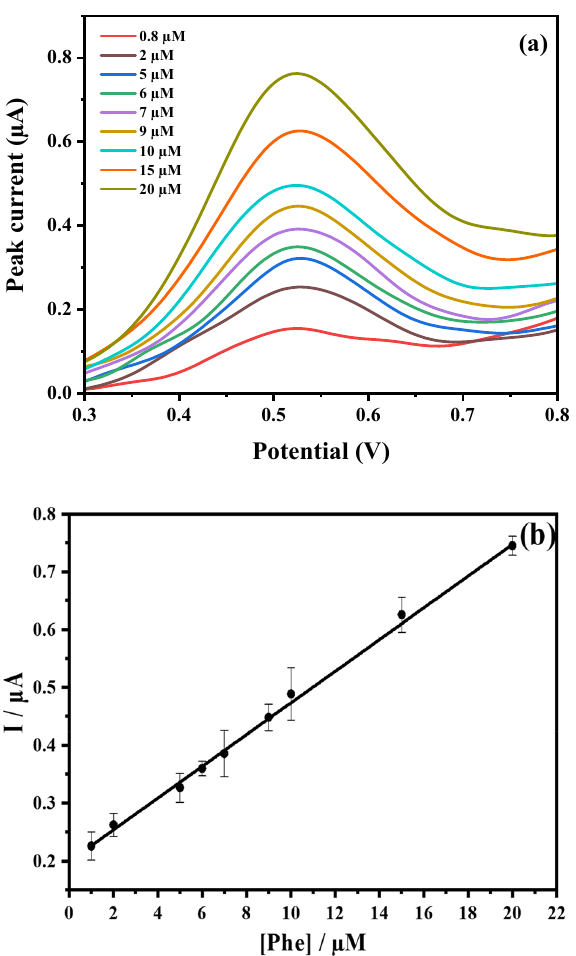
Figure 7. ( a ) DPV voltammogram recorded at AgNPs-M/GCE for increasing phenol concentrations (0.8, 2, 5, 6, 7, 9, 10, 15 and 20 µM) in PBS (0.1 M, pH 7.0), at the pulse time of 100 ms, pulse amplitude of 100 mV and at the scan rate of 60 mV s −1 ; ( b ) corresponding calibration